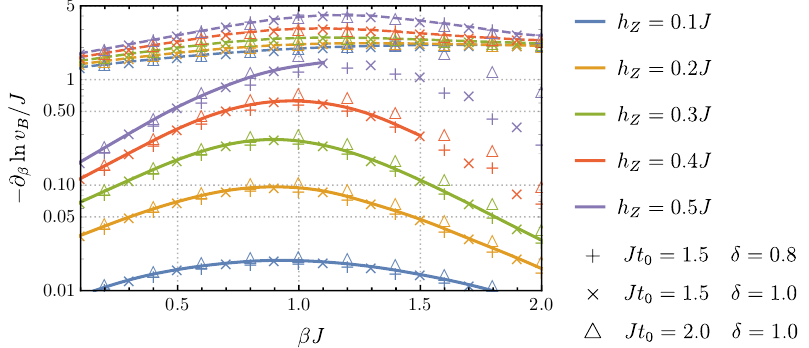
Figure 9: Temperature dependence of the butterfly velocity for different longitudi- = 1.05 J . Upper bounds are nal fields h and hyperparameters t and δ with h Z X 0 evaluated according to (23) shown as the dashed lines in the top of the